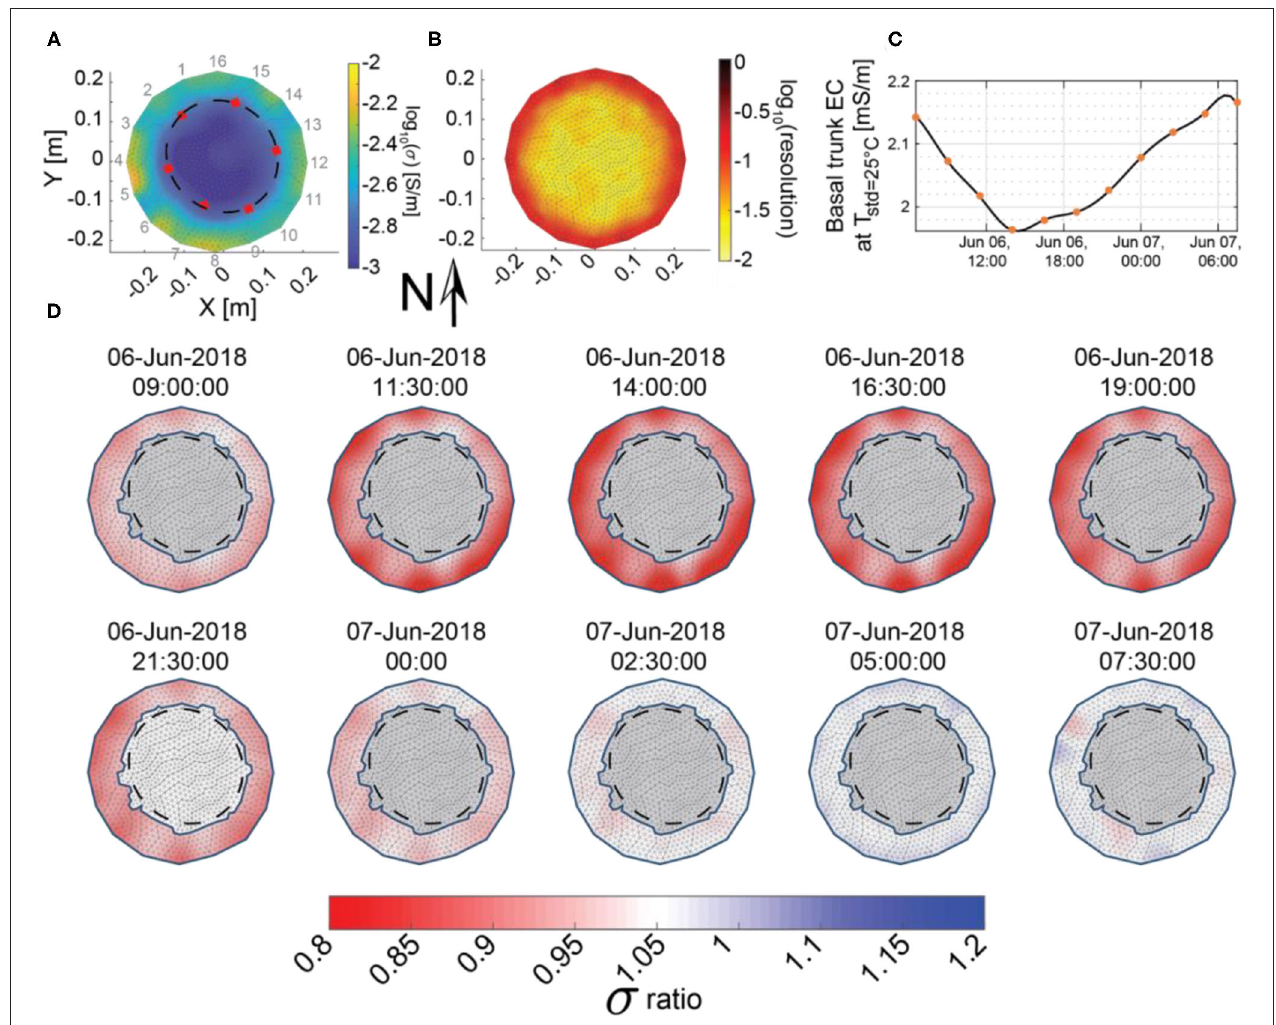
FIGURE 4 | (A) Electrical conductivity distribution on June 6 (a clear warm day used as time zero for the ERI differencing) at 06:30h, with electrode locations (1–16) around the outside and the location of heartwood/sapwood transition from tree cores (red squares) interpolated by a best-fit ellipse (black dashes). (B) Average diagonal of the resolution matrix for all 11 surveys between June 6 at 06:30h and June 7 at 07:30h, (C) spline interpolation (black line) of the median bulk apparent conductivity of the sapwood (orange squares) over a 25-h period, and (D) differences in inverted sapwood electrical conductivity with respect to the June 6 at 06:30 electrical conductivity model shown in (A) . Gray regions were removed from our analysis because these areas corresponded to the heartwood, which is not expected to significantly contribute to daily water use and because the ERI resolution was